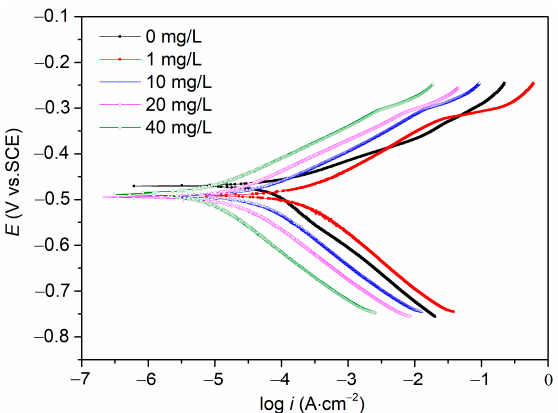
Figure 4. Potentiodynamic polarization curves of the carbon steel electrode immersed in 1 M HCl solutions with different contents of TSCA at 298 K.